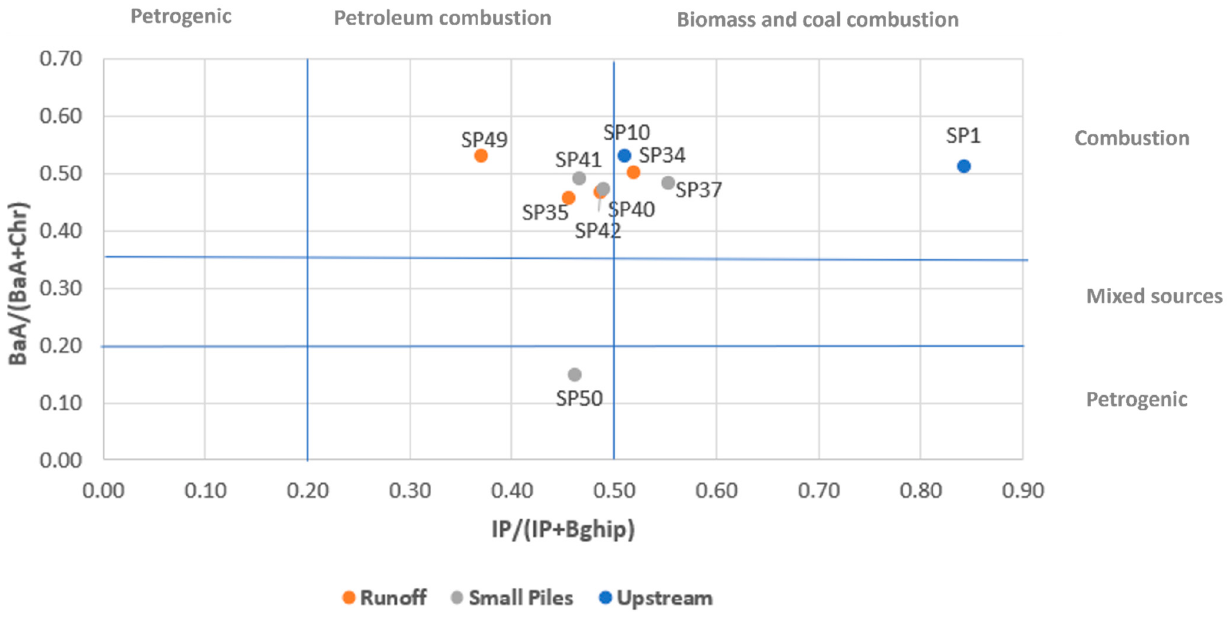
Figure 12. Cross plots for the isomeric ratios of BaA/(BaA + Chr) vs. IP/(IP + Bghip) on the topsoils of the surrounding area of the of São Pedro da Cova mine.